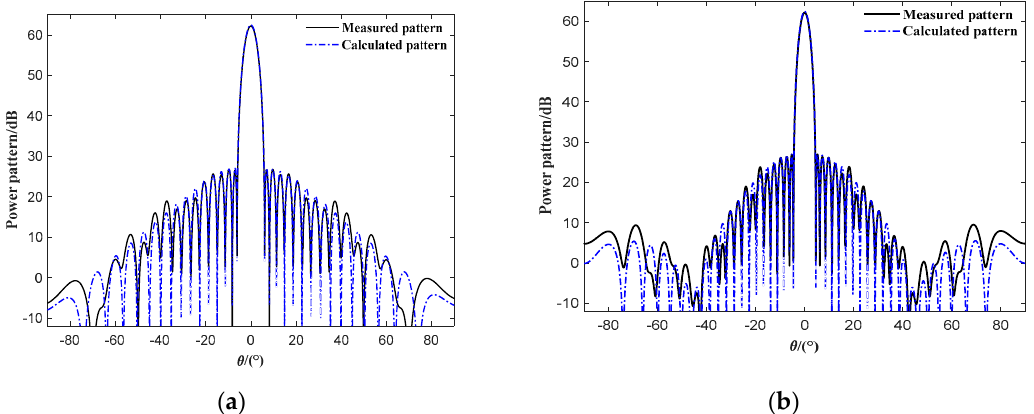
Figure 5. ( a ) Measured and calculated E-plane pattern; ( b ) measured and calculated H-plane pattern. It can be seen from Figure 5 that the measured and model-based calculated antenna patterns show good consistency in both the main and the first side lobe with a maximum error of 0.19 dB.